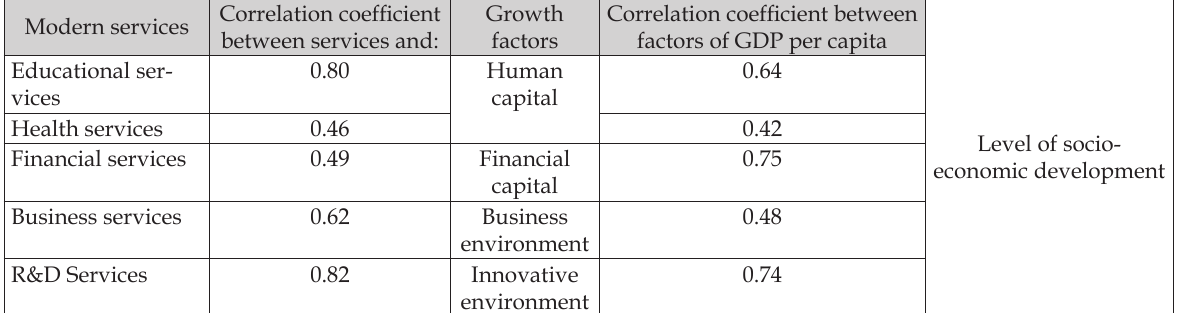
Table 3. The correlation coefficients between the level of development of modern services and development factors and the level of socio-economic